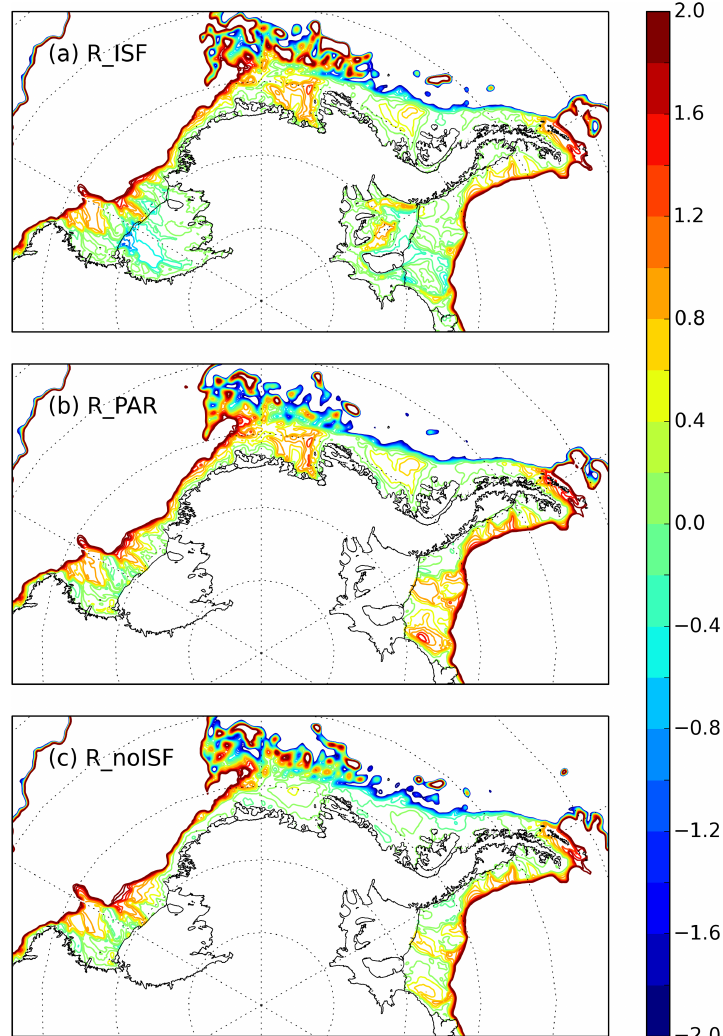
Figure 10. Barotropic stream function (Sv) on the Ross, Amundsen, Bellingshausen and Weddell continental shelves in (a) R_ISF, (b) R_PAR and (c) R_noISF. Stream function isolines out of the ± 2Sv range are not